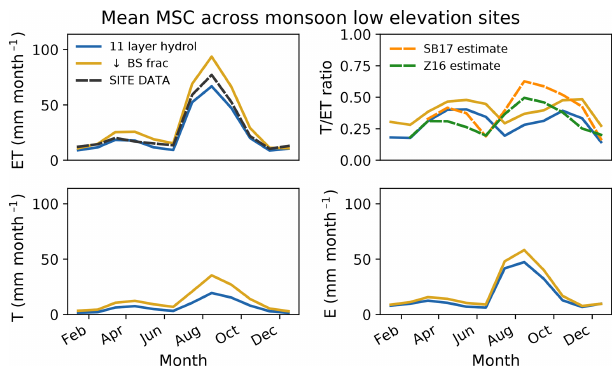
Figure 7. Monthly mean seasonal cycle for ET, T / ET ratios, T , and E averaged across all low-elevation grass- and shrub-dominated sites comparing the default 11LAY simulations (blue curve) with a simulation in which bare soil fraction is decreased. C 4 grass cover increased (yellow curve). ET is compared to observations (black dashed curve) and T / ET ratios are compared to the data-derived estimates from Scott and Biederman (2017 – orange dashed curve) and Zhou et al. (2016 – green dashed curve). Units are millimeters per month (mmmonth − 1